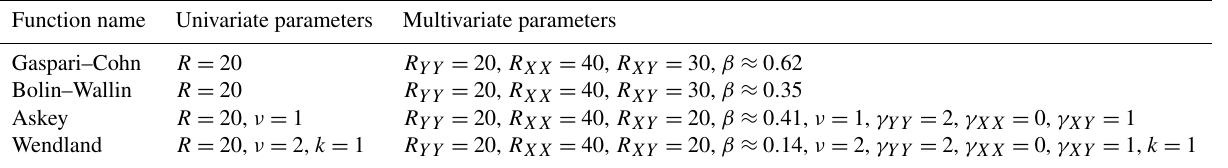
Table B1. Localization parameters for the experiment where we observe only the large process.